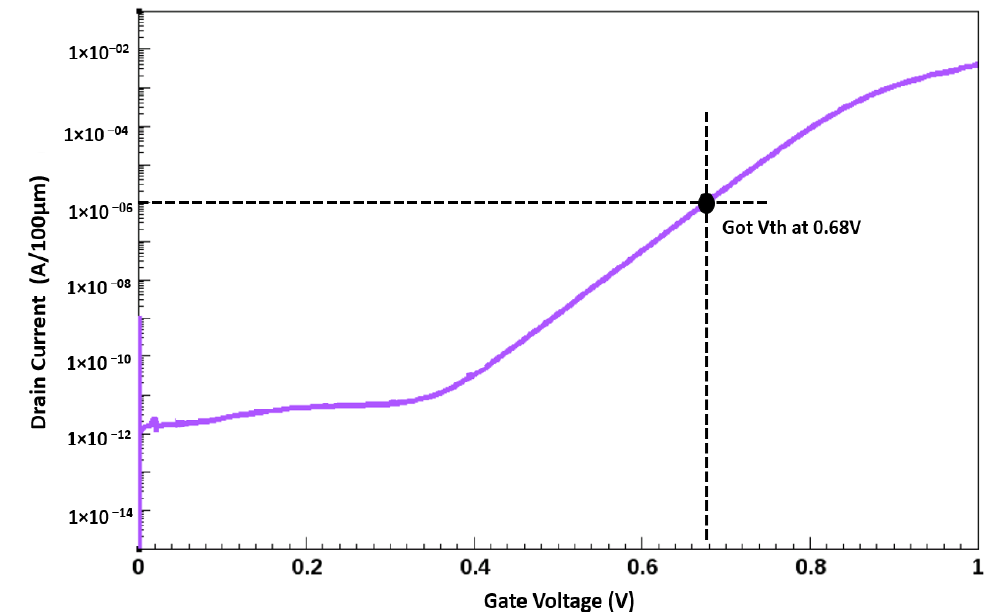
Figure 7. Vth Curve for AlGaN/GaN with nitrogen implanted gate HEMT .